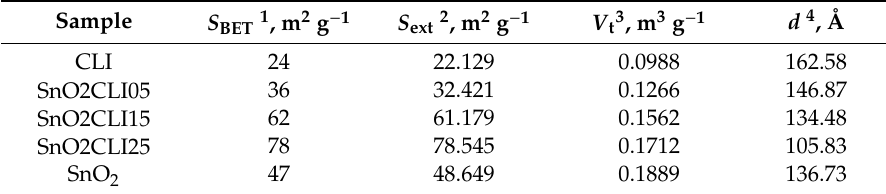
Table 2. Textural properties of the samples.